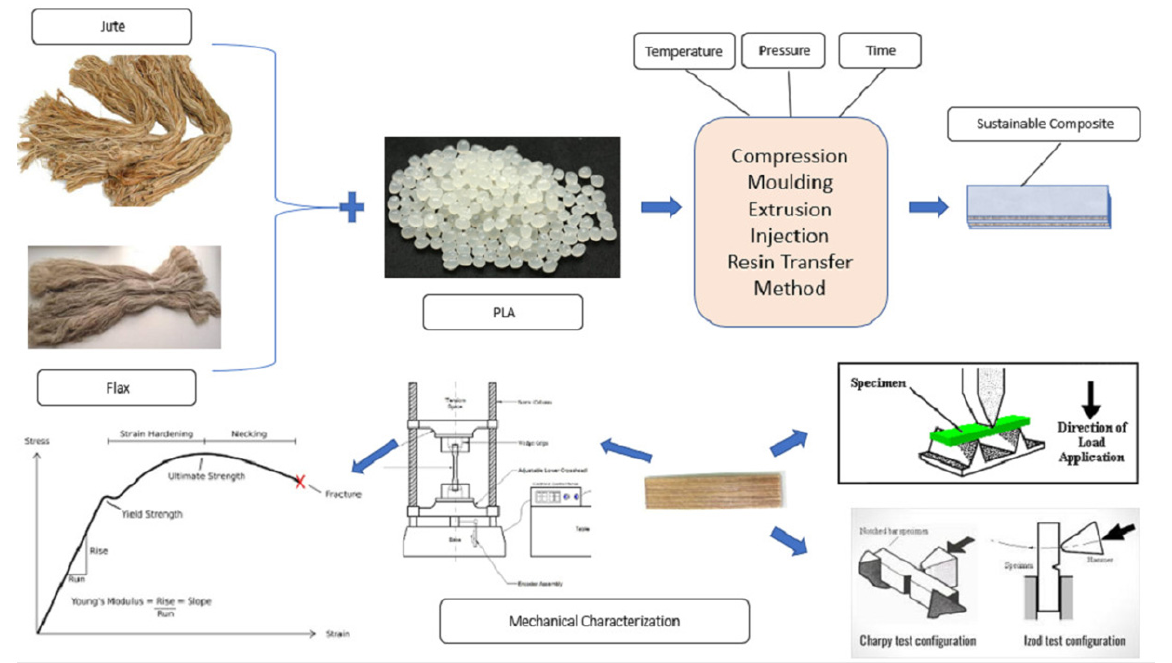
Figure 5. Schematic illustration of preparation and characterization of sustainable composites produced from PLA and flax/jute fibers. Reprinted from [79].